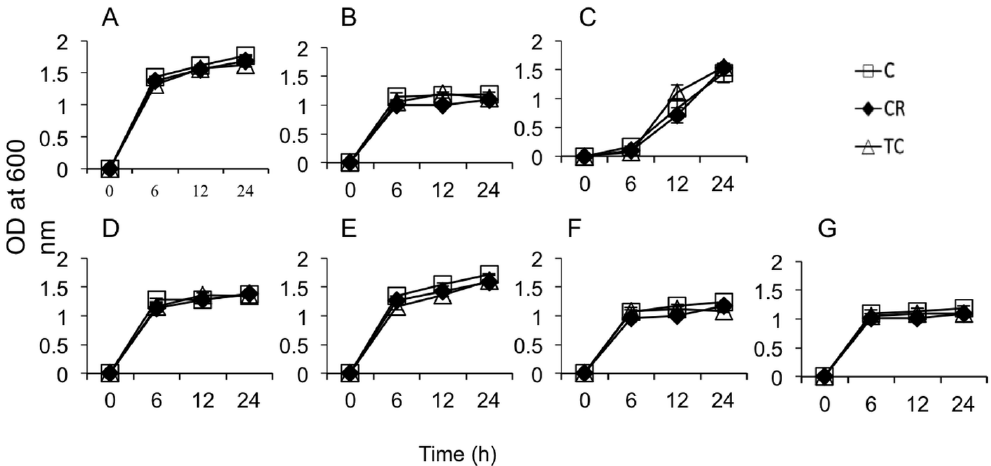
Figure 1. Effect of Sub-inhibitory concentrations of carvacrol (CR) and trans -cinnamaldehyde (TC) on beneficial gut bacterial growth. Seven selected beneficial gut bacteria ( Lactobacillus brevis ( A ); L. reuterii ( B ); L. delbrueckii bulgaricus ( C ); L fermentum ( D ); L. plantarum ( E ); Bifidobacterium bifidum ( F ); and Lactococcus lactis lactis ( G )) were grown in de Man, Rogosa and Sharpe broth in anaerobic condition at 37 °C with and without SICs of CR and TC (Control-Ctrl, open square, Carvacrol-CR, closed diamond, trans -cinnamaldehyde-TC, open triangle) for 24 h. The bacterial growth was monitored by measuring optical density at 600 nm measured at 6, 12 and 24 h. TC- or CR-treated gut bacterial populations did not change significantly from the controls ( p >